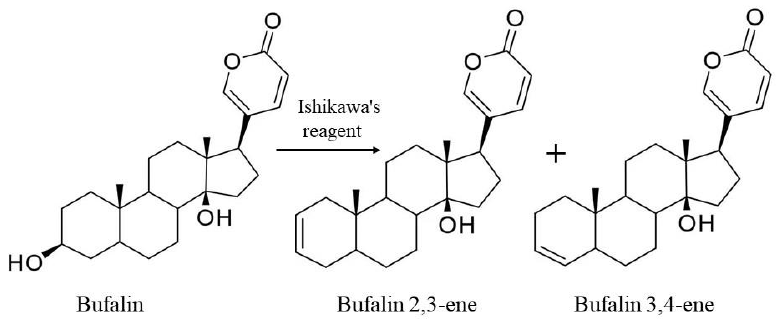
Figure 5. Chemical structures of bufalin, bufalin 2,3-ene, and bufalin 3,4-ene.